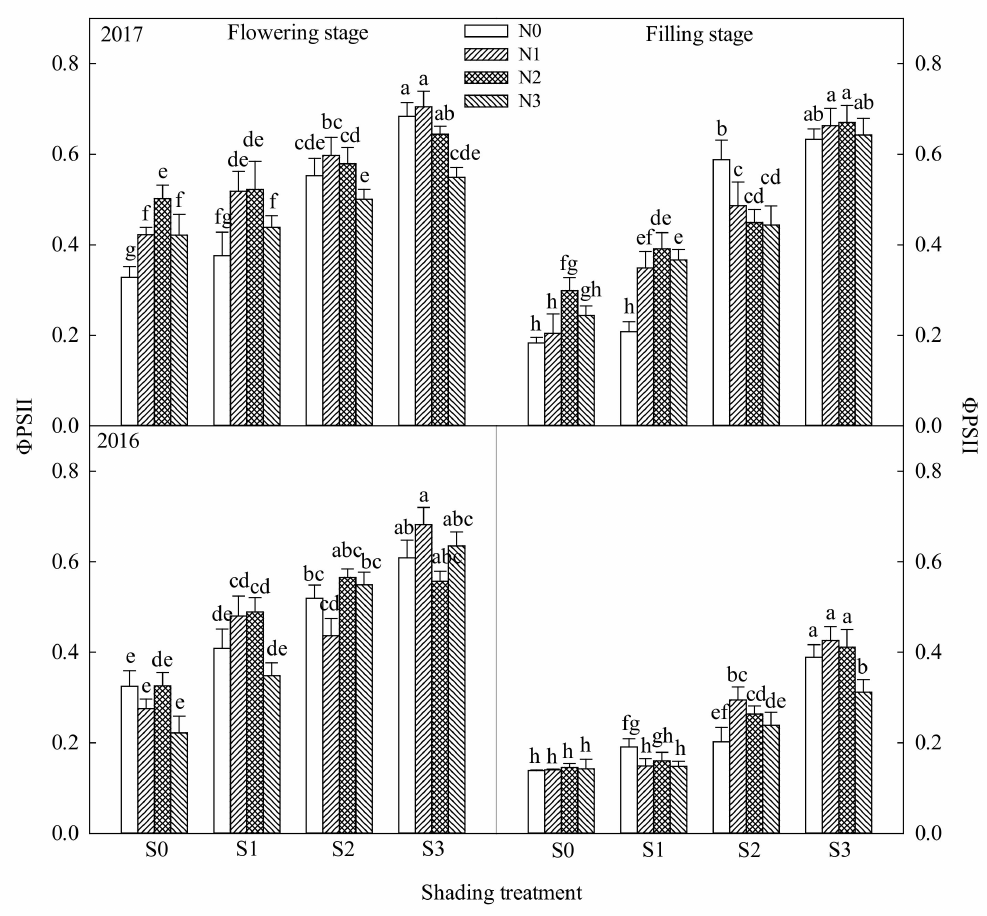
Figure 7. Effect of light and nitrogen treatment on the quantum efficiency of PSII ( Φ PSII) of wheat. Bars indicate SD (n = 3). Values within columns followed by the same letter are statistically insignifi- cant at the 0.05